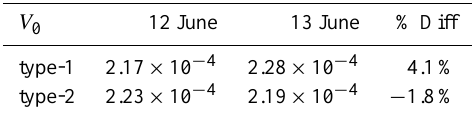
Table 1. Retrieval of V 0 for stable and unstable water vapour time pattern cases, using type-1 and type-2 modified Langley